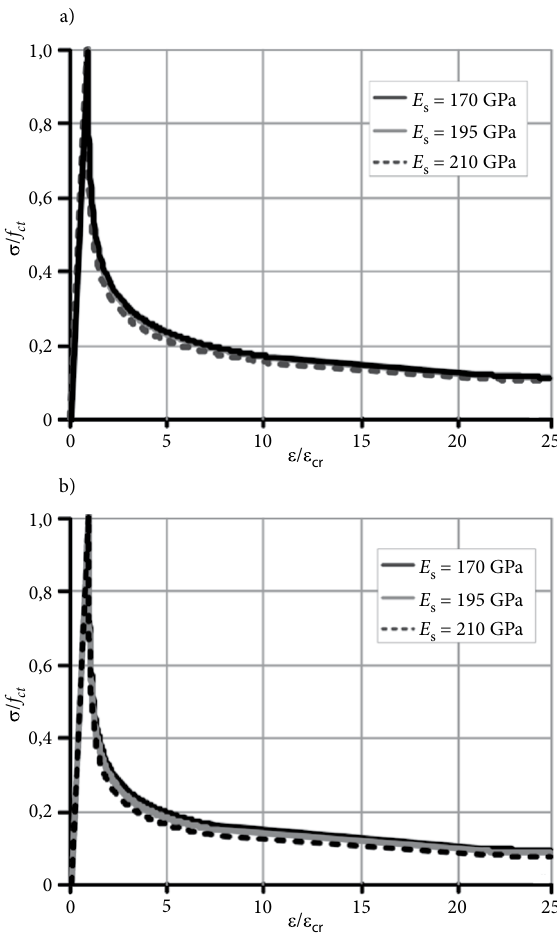
8 pav. Skaitiškai nustatytos betono tempiamojo sustandėjimo diagramos, kintant armatūros tamprumo moduliui: a - r = 1,0 %; b - r = 2,0 % Fig. 8. Numerically derived tension stiffening diagrams of varying an elastic modulus of reiforcement: a - r = 1,0 %; b - r = 2,0